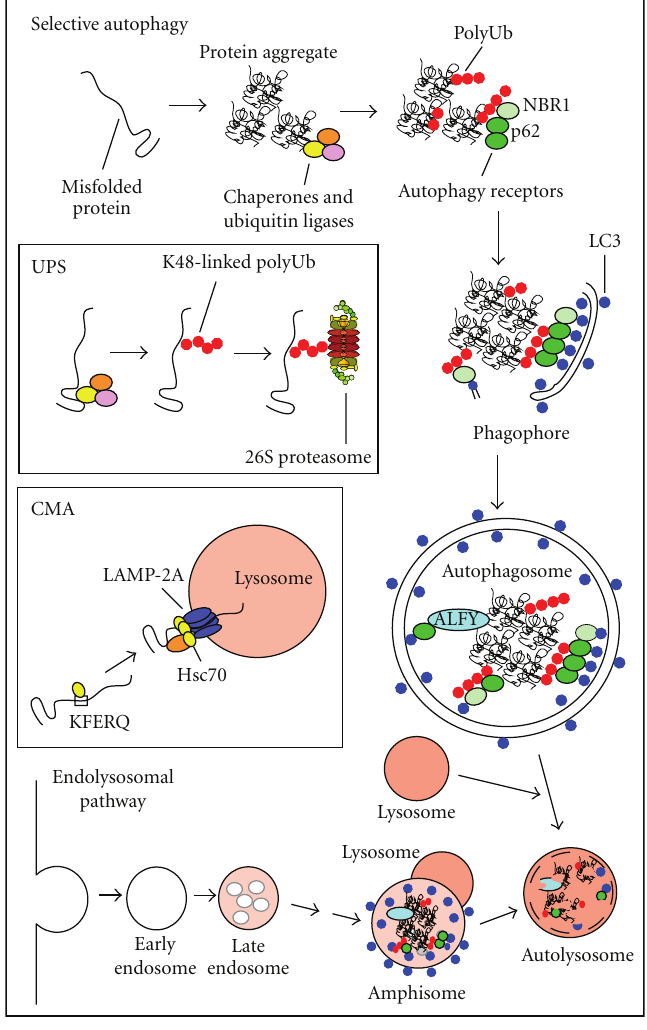
Figure 1: Proteins recognized as misfolded by molecular chaperones can be degraded by selective autophagy, the ubiquitin-proteasome system (UPS) or chaperone-mediated autophagy (CMA). In selective autophagy, misfolded proteins are often assembled into aggregates before they are degraded. They are also often ubiquitinated, and this induces the recruitment of ubiquitin binding cargo receptors such as p62 and NBR1. These cargo receptors bind to ubiquitinated cargos (in this case a protein aggregate) and to ATG8 homologues conjugated to the inner surface of the phagophore (LC3 indicated as blue dots). This way, cargos are selectively delivered to the inner surface of the phagophore. An autophagosome is formed by closure of the phagophore. The autophagosome fuses with a late endosome or with a lysosome, but the end point is in both cases the formation of an autolysosome where the contents are degraded. Substrates for the UPS and CMA degradation pathways need to be in a soluble and monomeric form. Degradation by the UPS depends on K48-linked polyubiquitination of the misfolded substrate. The substrate is then delivered to the 26S proteasome, where it is deubiquitinated and degraded. Degradation by CMA depends on an Hsc70-mediated recognition of a KFERQ motif on the misfolded substrate. The substrate is then delivered to the lysosomal receptor LAMP-2A, transported into the lumen of the lysosome, and